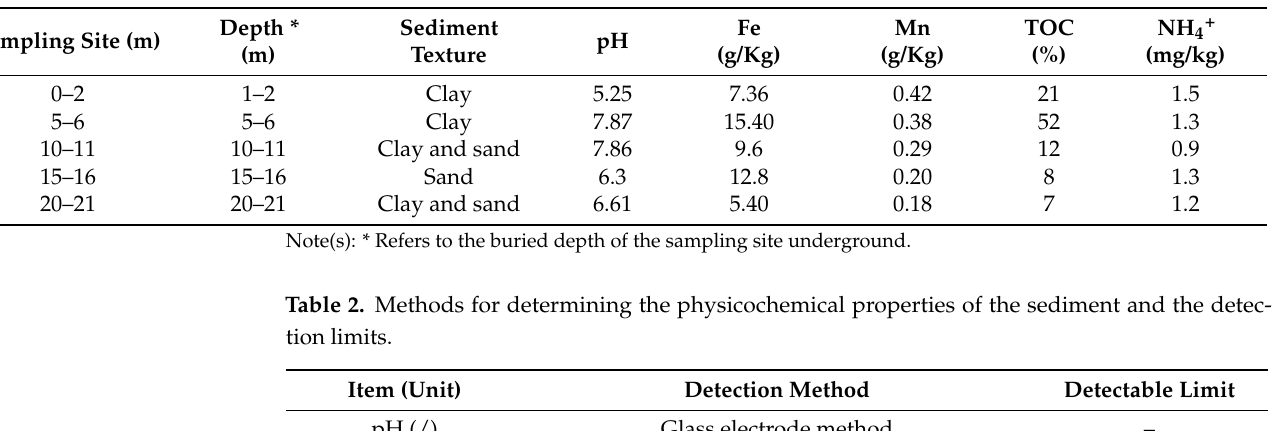
Table 1. Physical and chemical properties of the aquifer sediments used for the experiment.